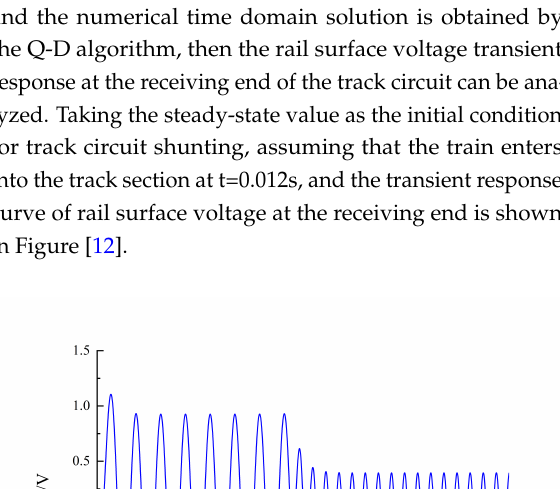
Fig. 10. Transient response of rail surface voltage under different transmission distances.